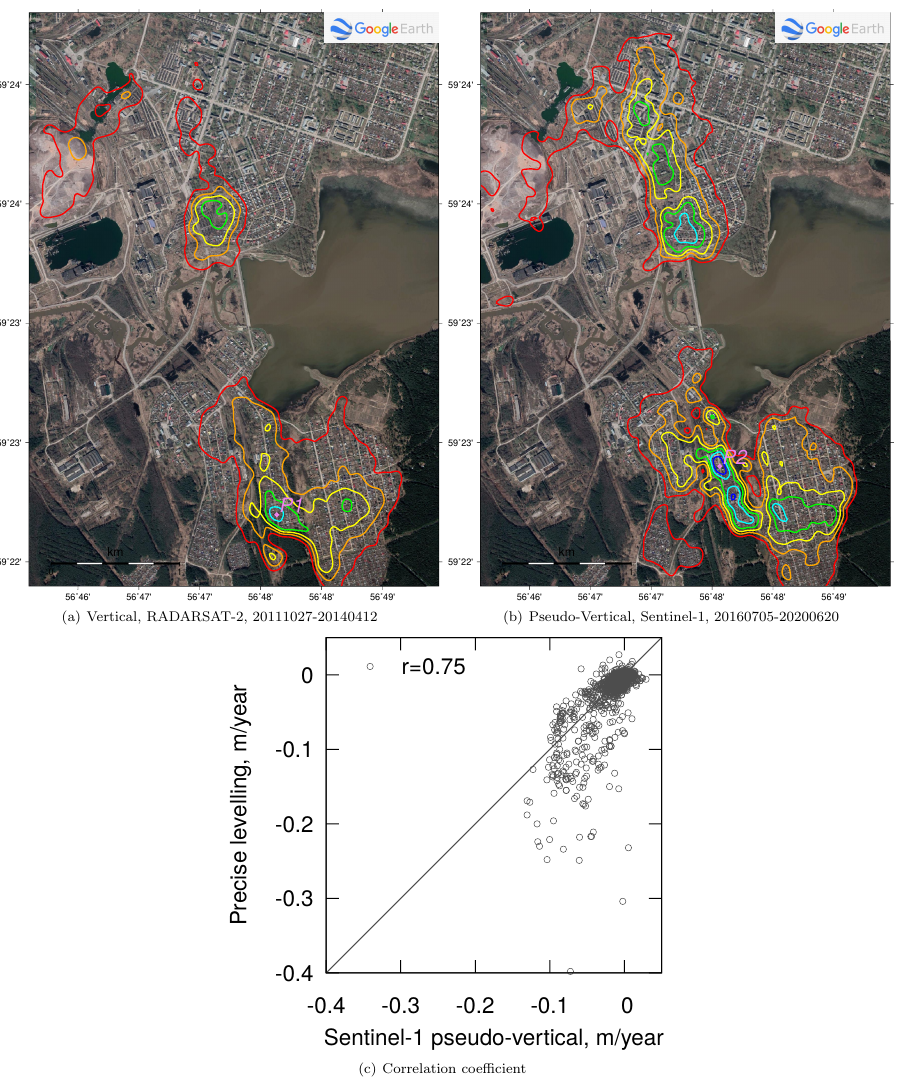
Figure 4. RADARSAT-2 vertical ( a ) and Sentinel-1 pseudo-vertical ( b ) deformation rate during 27 October 2011–12 April 2014 and 5 July 2016–20 June 2020, respectively, shown as colour-coded contours: red ( − 0.02 m/year), orange ( − 0.04 m/year), yellow ( − 0.06 m/year), green ( − 0.08 m/year), cyan ( − 0.10 m/year), blue ( − 0.12 m/year). Background imagery is from Google Earth Pro V